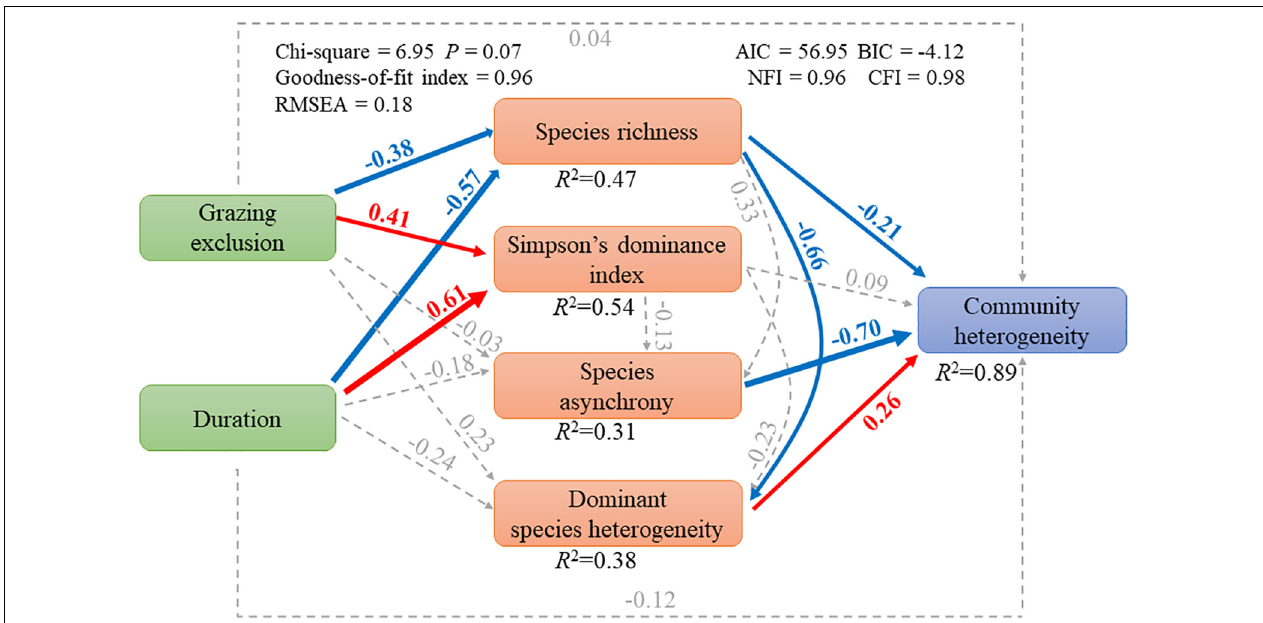
FIGURE 6 | A full structural equation model (SEM) of the effects of grazing exclusion and its duration of application on community spatial heterogeneity. Grazing exclusion and its duration can influence community spatial heterogeneity through species richness, Simpson’s dominance index, species asynchrony, and dominant species stability. Red and blue solid arrows indicate significant positive and negative pathways, respectively. Gray dashed arrows represent the pathways that are not significant. Arrow width indicates the strength of the relationship between variables. The standard path coefficients are marked above the arrow. The magnitude of R 2 is proportional to the variance explained by each dependent variable in the SEM. AIC, Akaike information criterion; BIC, Bayesian information criterion; NFI, normed fit index; RMSEA, root mean square error of approximation; CFI, comparative fit index. All criteria are within acceptable scope.